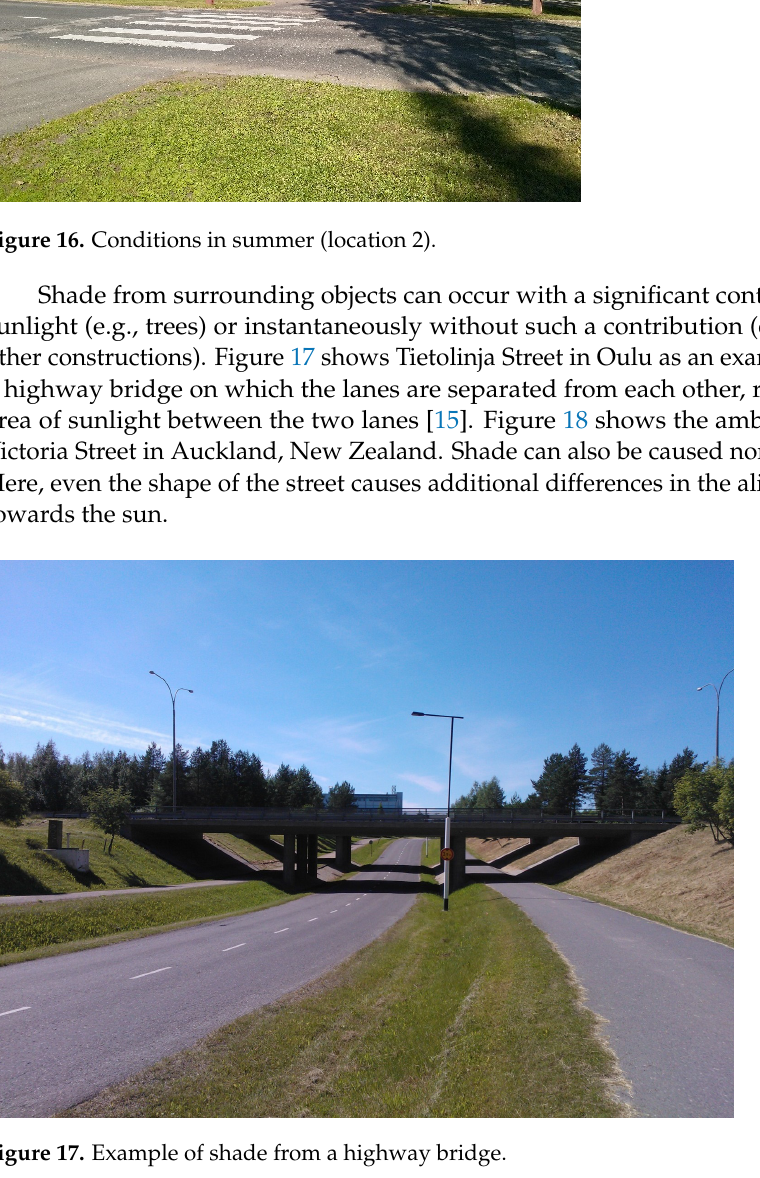
Figure 16. Conditions in summer (location 2).